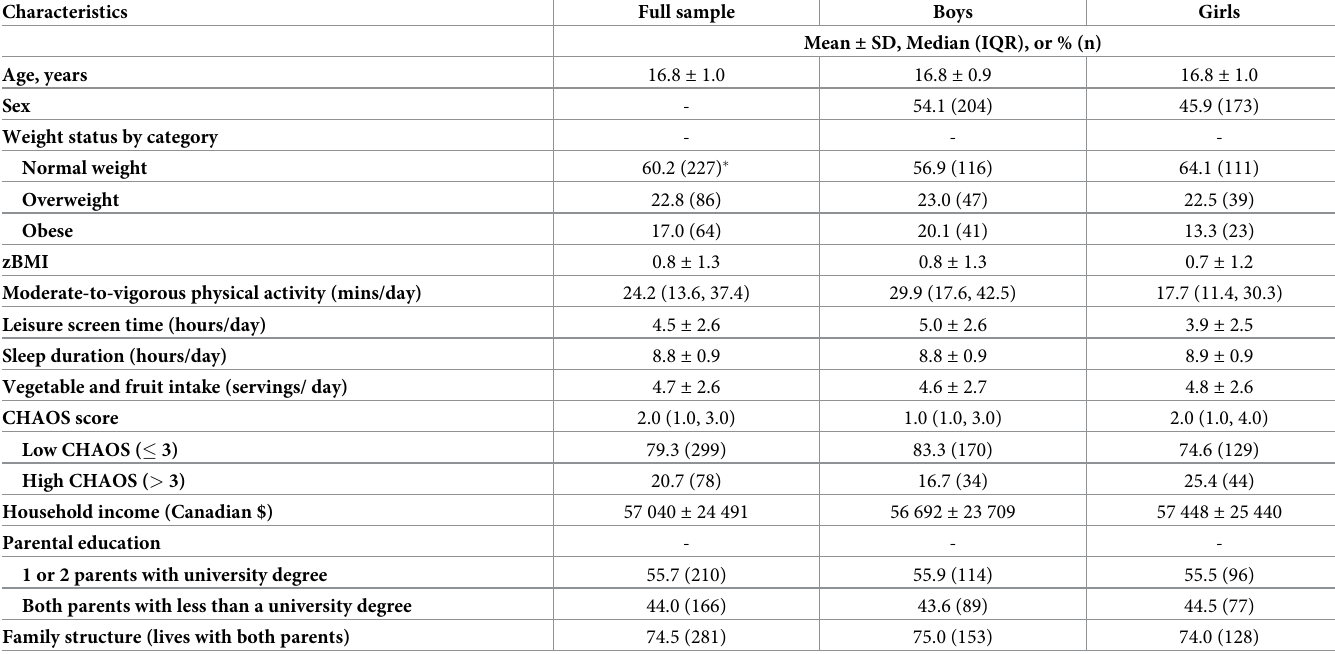
Table 1. Characteristics of participant, QUALITY cohort study, visit 3 (n =